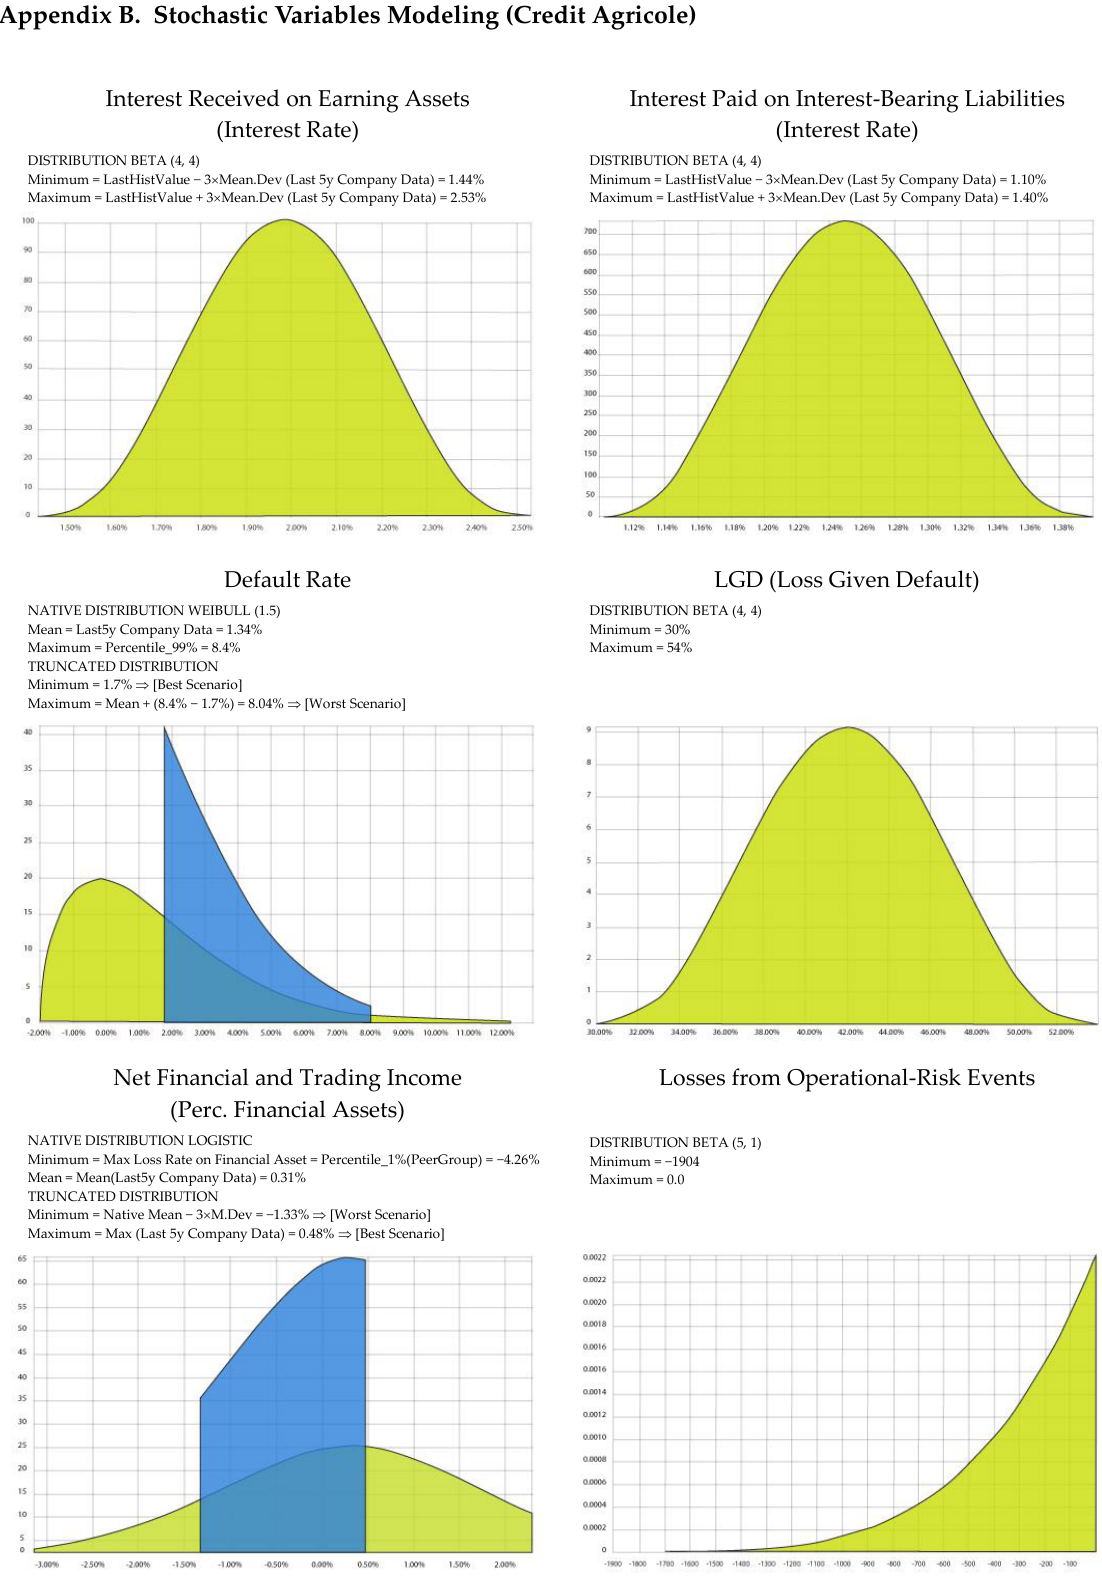
Figure A4. Probability distribution functions of key stochastic variables for Credit Agricole simulation.